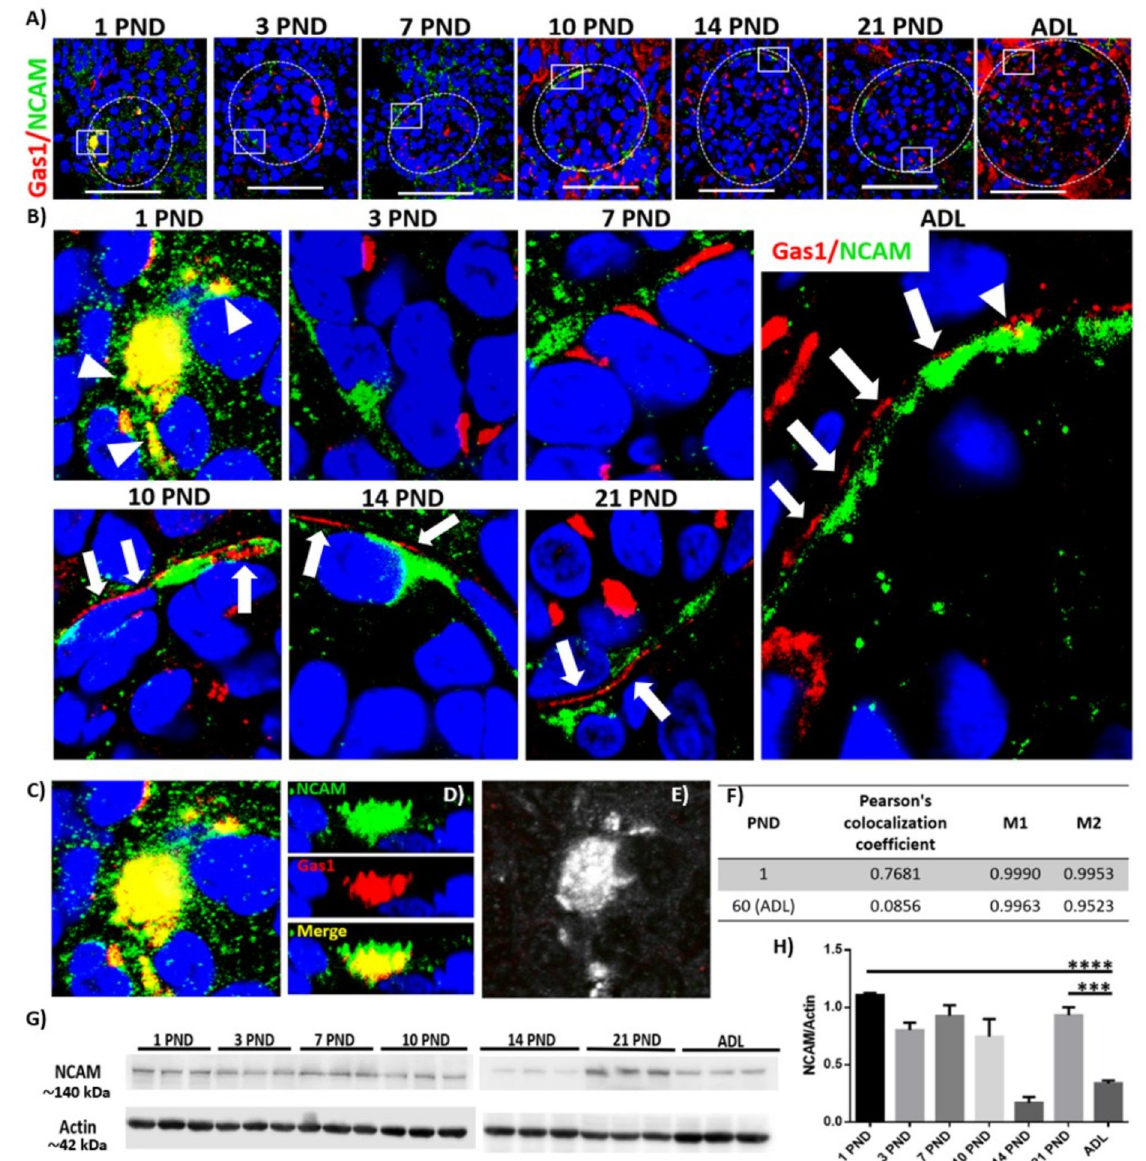
Fig 3. Gas1 and NCAM in the glomerulus and Bowman’s capsule during postnatal renal development and in adulthood of the rat. A) Immunofluorescence of the general expression pattern of Gas1 and NCAM in the glomerulus during the different postnatal days (PND) evaluated. NCAM is expressed in the glomerulus and Bowman’s capsule (BC) and co-localizes with Gas1. B) magnification of the boxes in A, NCAM is expressed intraglomerularly to PND 1 and colocalized with Gas1 (arrowhead), as the kidney matures, colocalization decreases, but they remain very close to each other in the BC (white arrows). Two types of analysis were made to confirm the colocalization of Gas1 and NCAM to PND 1 (C), the first was qualitative with a Z-stacks of the colocalization zone (D); and the second quantitative, by calculating the Pearson colocalization coefficient (PND 1 r = 0.7681, ADL r = 0.0856, F), that generates a colocalization map (E, the areas where the two proteins colocalize in PND 1 are seen in white) and the calculation of the Manders coefficient (PND 1 M1 = 0.9990 and M2 = 0.9953, ADL M1 = 0.9963 and M2 = 0.9523). G and H) analysis of NCAM expression by Western blot in an enriched sample of glomeruli, we find that the highest expression is in PND 1, 7 and 21, and the lowest expression is in PND 14 and ADL. Each PND analyzed is expressed as the relative density of a group of 20 (younger ages) and 8 (21 PND and adult) rats normalized with actin as loading control. Gas1 (red), NCAM (green), Merge (yellow) and nuclei with DAPI (blue) are shown. The glomerulus is delimited by a white circular line. The white squares represent the magnification of specific areas in the glomerulus. Scale bars = 50 μ m. Values are means ± standard deviation (SD). One-way ANOVA. * p < 0.05, **** p < 0.0001. Immunofluorescence experiments were performed in kidney sections. A representative experiment is shown (n = 3).